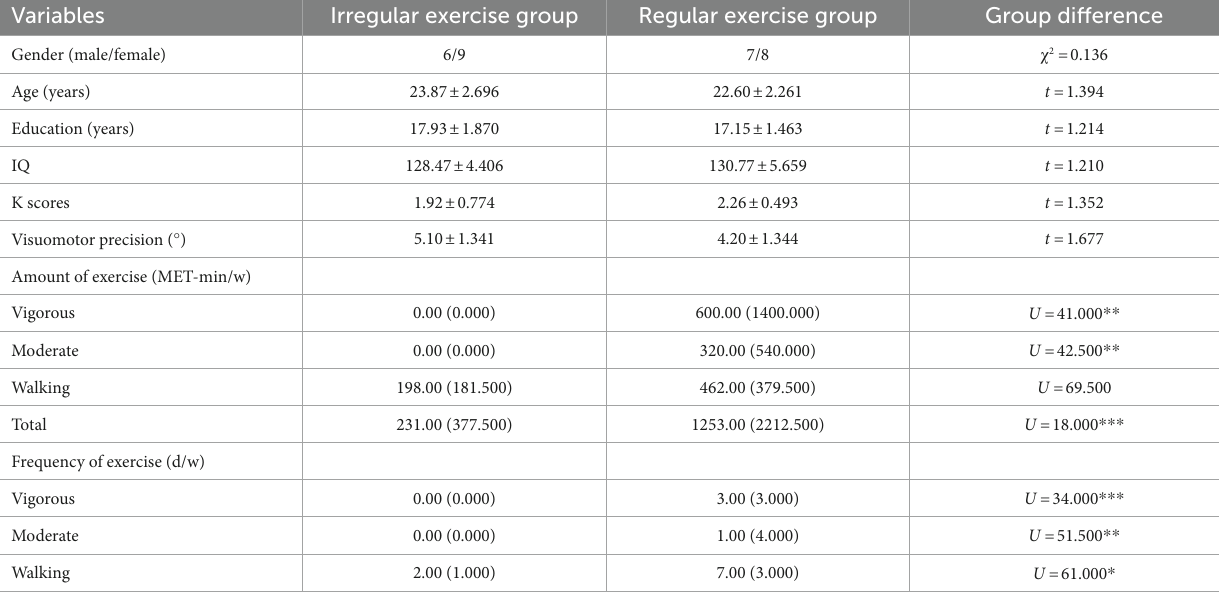
TABLE 1 Demographic information, cognitive abilities, and exercise variables of the two